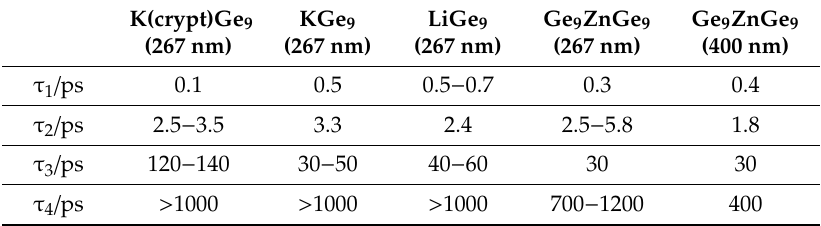
Table 1. Time constants from global analysis after UV (267 nm) and additionally 400 nm excitation for Ge 9 ZnGe 9 .